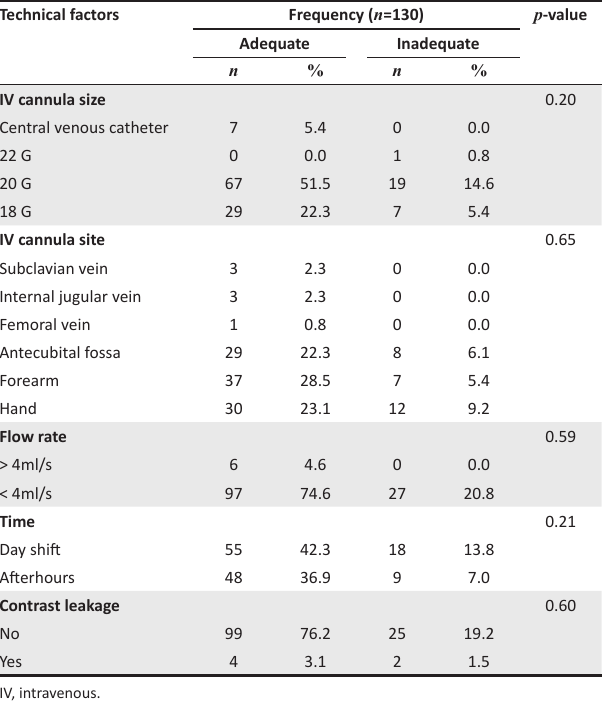
TABLE 1: CTPA technical factors. Technical factors